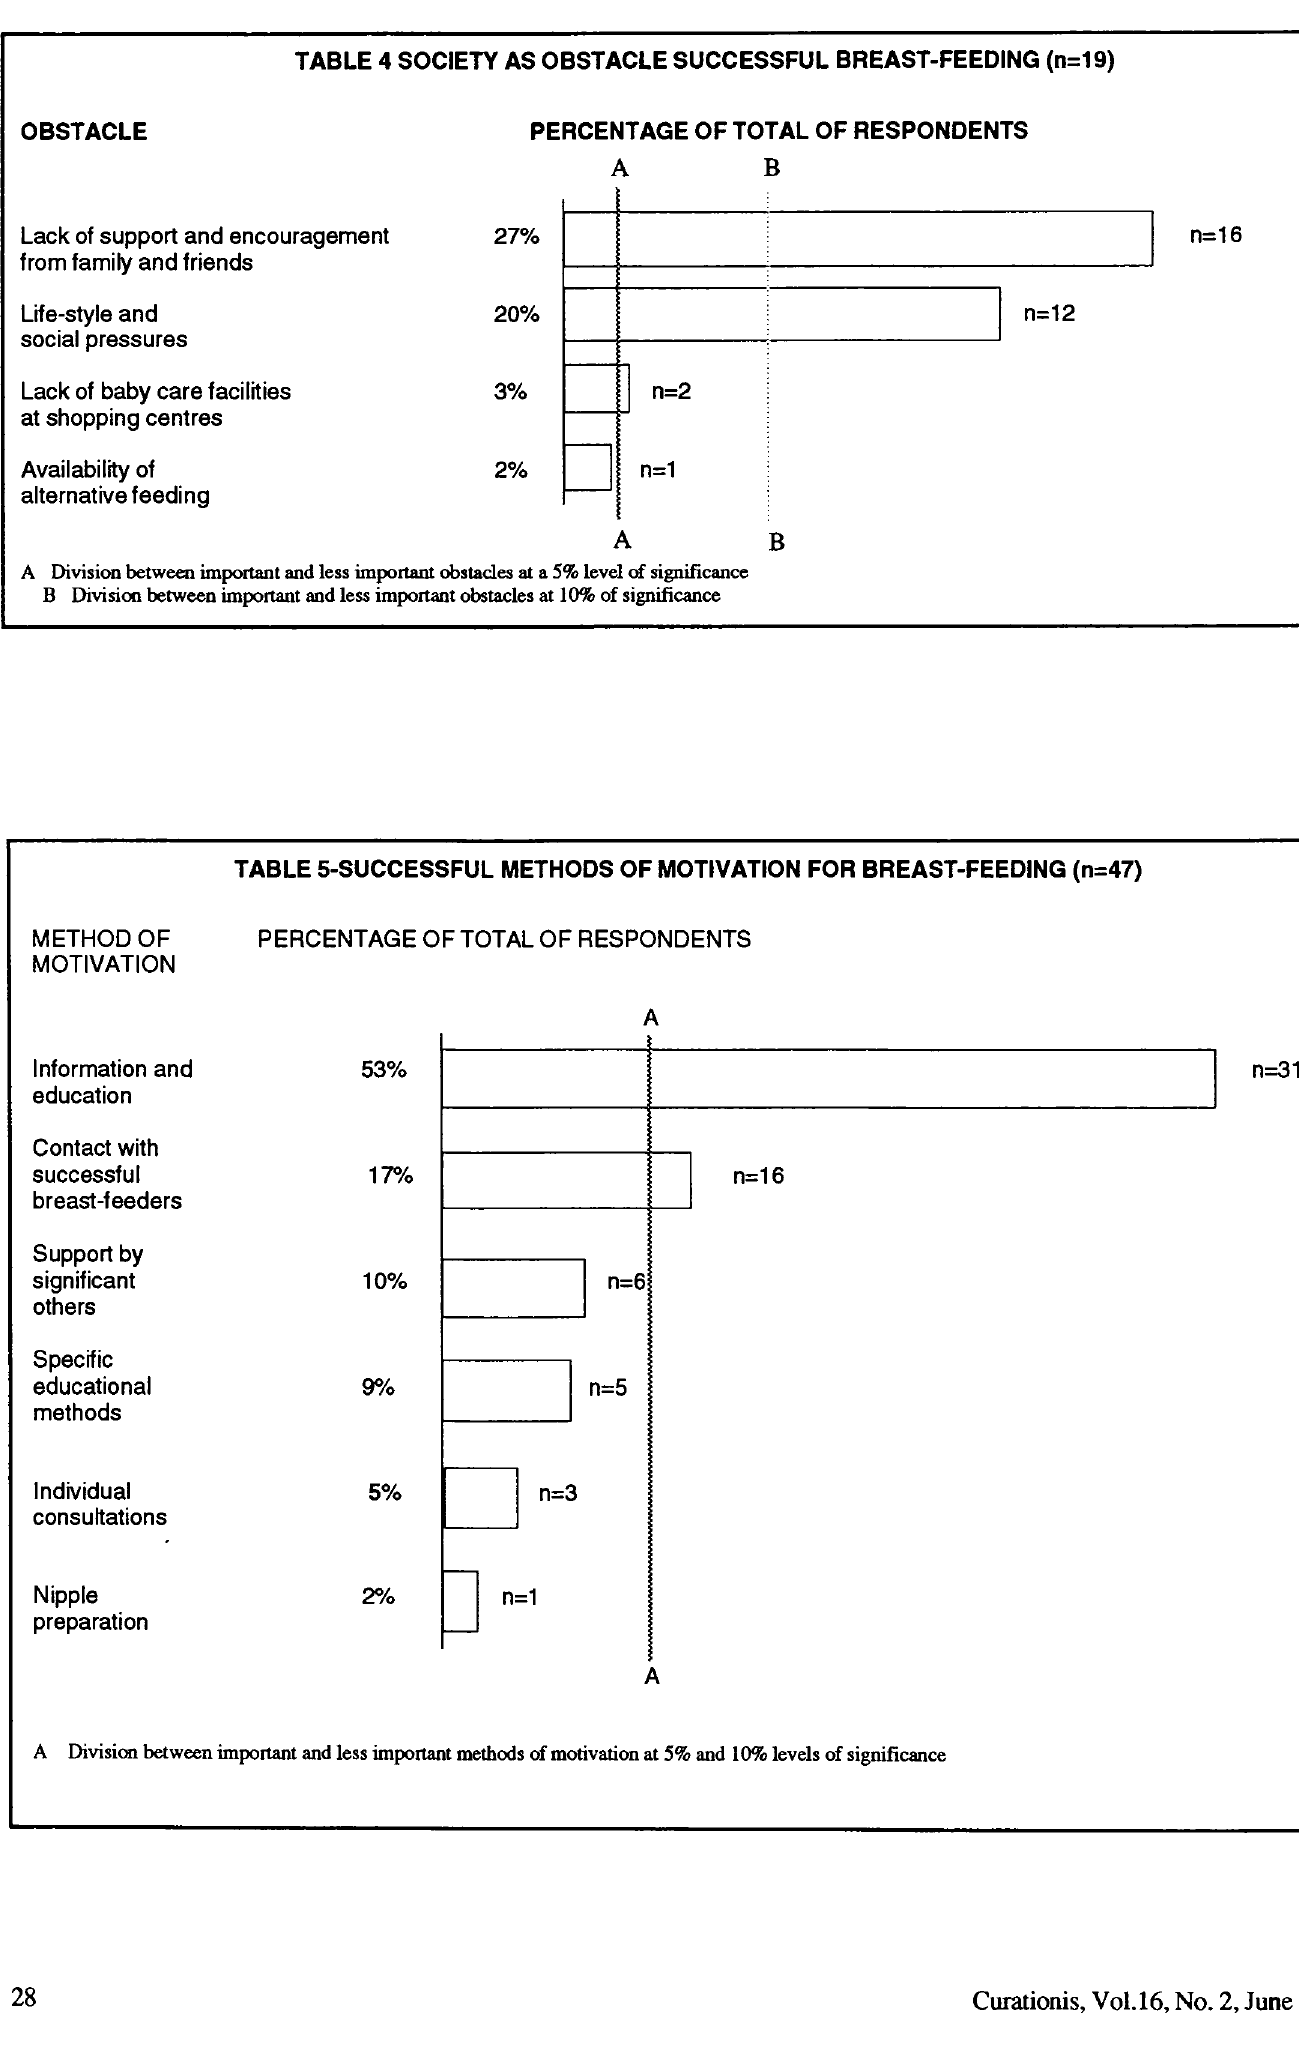
TABLE 5-SUCCESSFUL METHODS OF MOTIVATION FOR BREAST-FEEDING